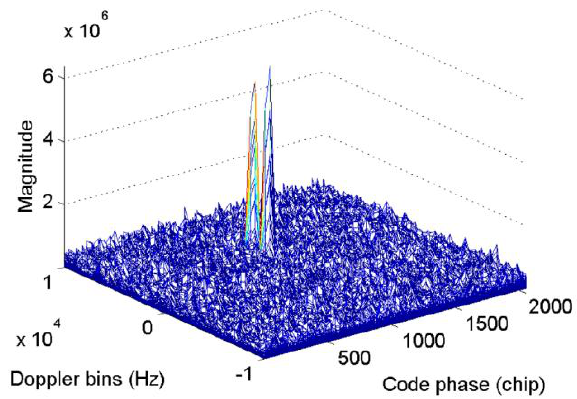
Figure 3. Acquisition results with simulated signal of satellite 12.